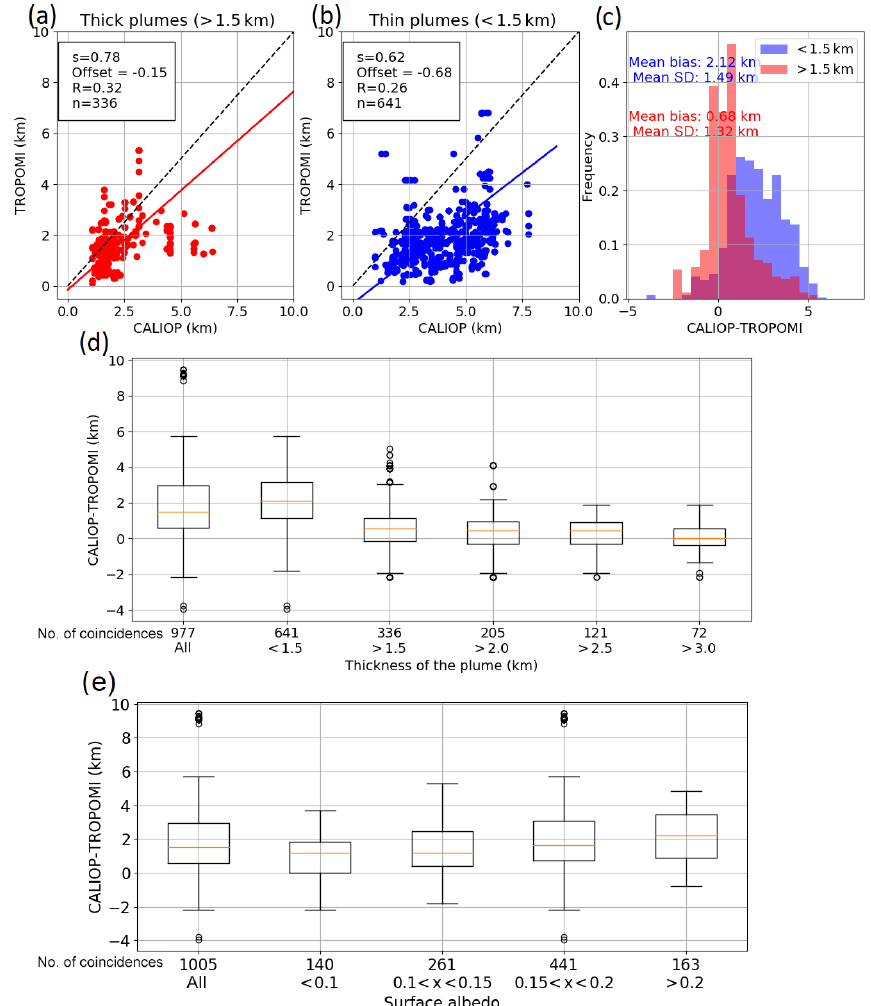
Figure 4. CALIOP–TROPOMI comparison for (a) geometrically thick plumes ( > 1 . 5km) and (b) geometrically thin plumes ( < 1 . 5km), together with the statistics of the line of best fit (correlation coefficient, R , slope, s , and number of observations, n ). The plume thick- ness is determined by the CALIOP top and base plume height. Panel (c) shows the histogram for the differences in plume height (CALIOP − TROPOMI) for thick (red) and thin (blue) plumes. Panel (d) shows the statistics for different plume thickness filters and (e) for different ranges of surface